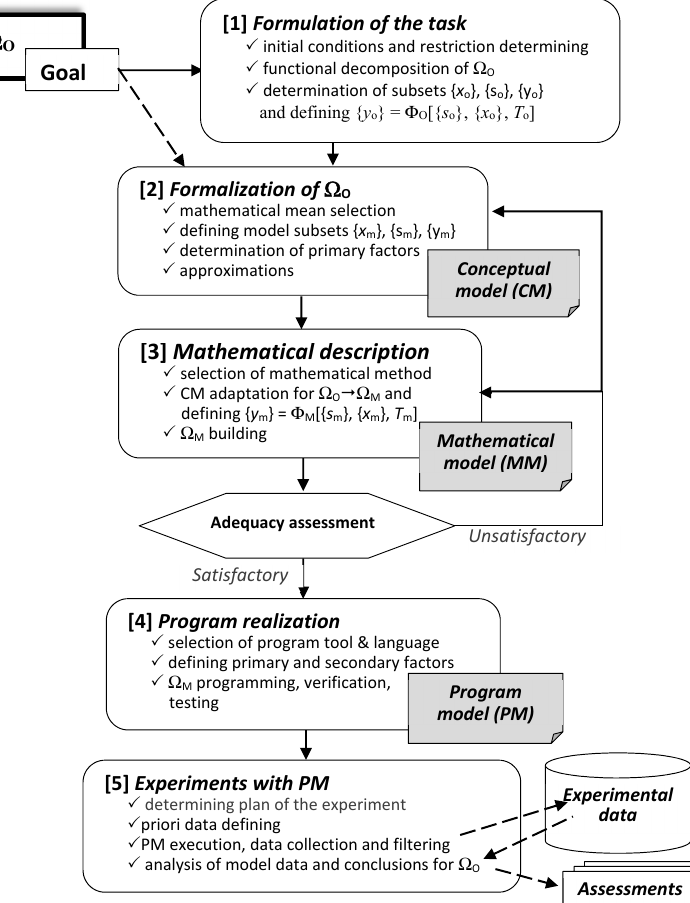
Figure 1. Generalized formal procedure for organization of model investigation.